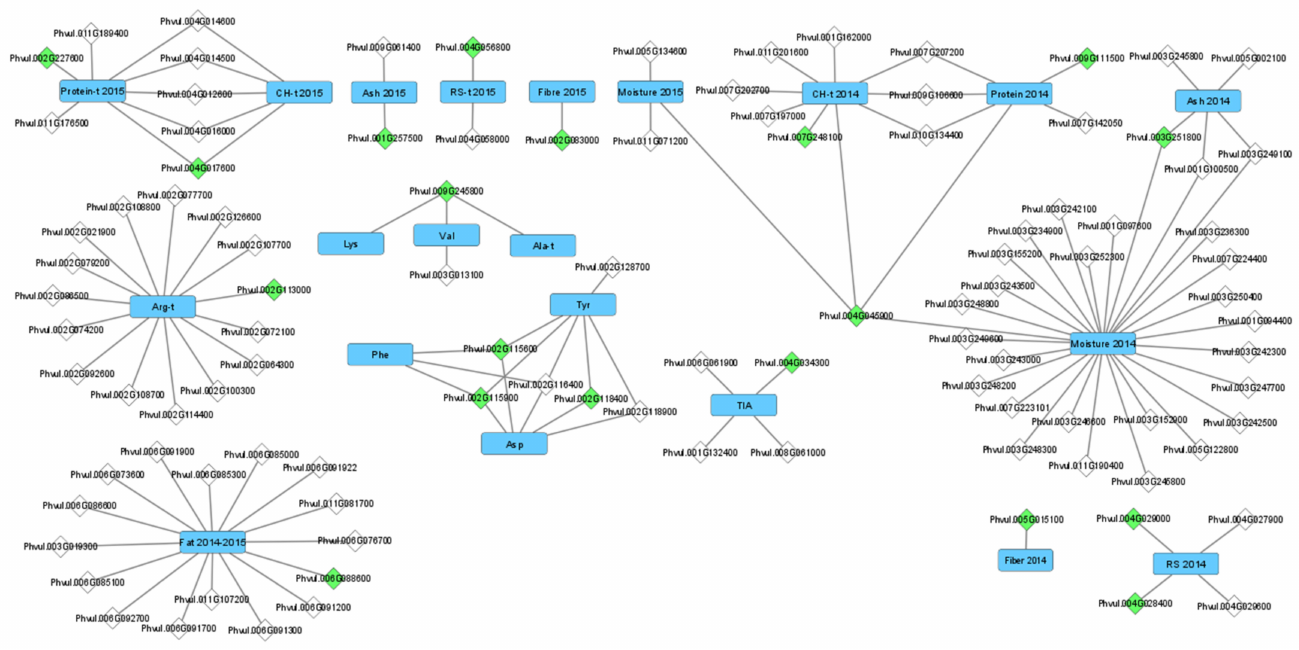
Figure 4. Network analysis of the candidate genes proposed for the nutritional quality traits using 106 Portuguese common bean accessions grown in two contrasting environments (Cabrela and C ó rdoba), using Cytoscape software. Traits represented as rectangles; genes represented as diamonds. Genes identified by green diamonds correspond to candidate genes for the SNP markers associated with the highest P-value for each trait. Traits are identified as: 2014-Cabrela; 2015-C ó rdoba; 2014– 2015 — both environments; “-t” — trait data transformed following a Box-Cox transformation. CH-carbohydrates; RS-resistant starch; Ala-alanine; Arg-arginine; Asp-aspartic acid; Lys-lysine; Phe-phenylalanine; Tyr-tyrosine; Val − valine; TIA-trypsin inhibitor